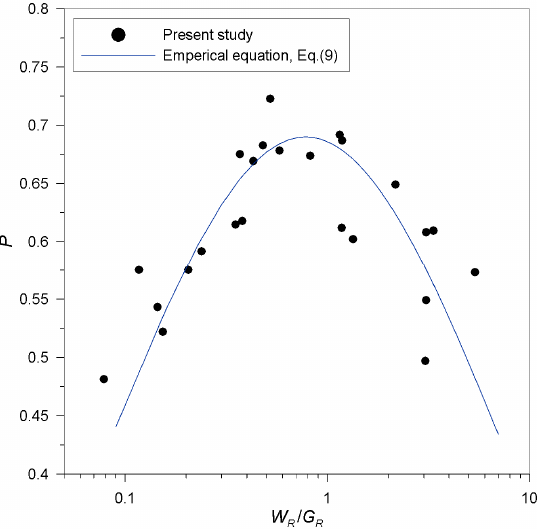
Figure 10. Relationship between visual preference ( P ) and ratio of water to greenery ( W R / G R ).